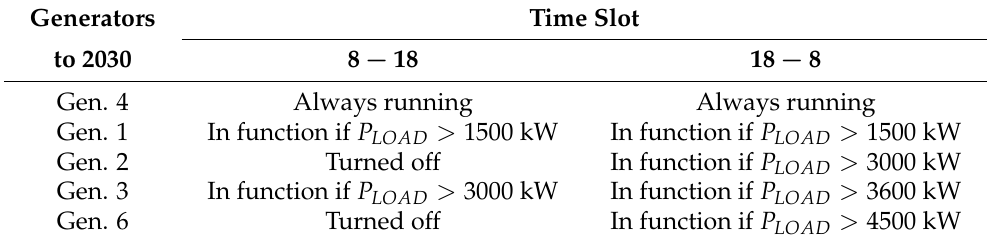
Table 18. Possible control logic of diesel groups by 2030: Summer. Generators